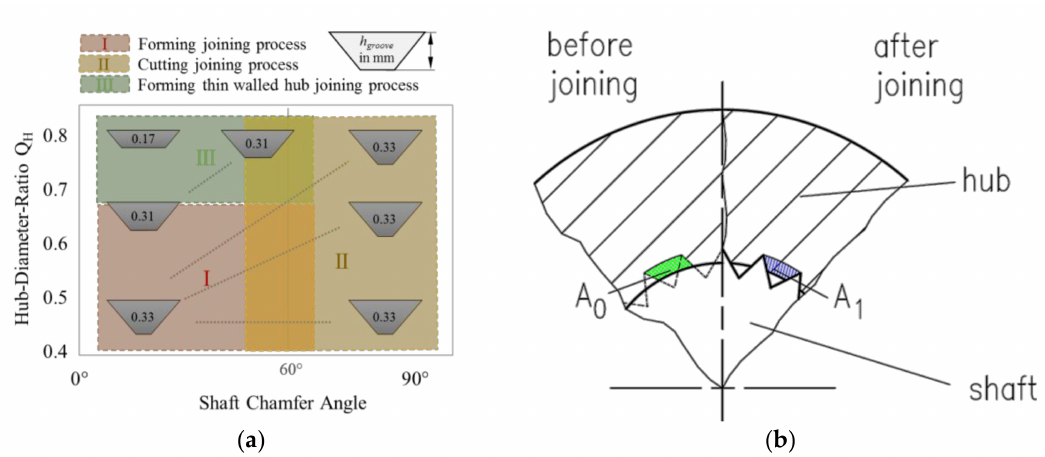
Figure 4. ( a ) Hub groove height formation after KIF joining; and ( b ) calculation areas for equivalent plastic strain ε pl RPV